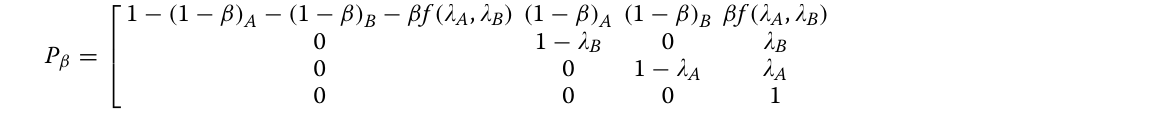
The Markov state transition β-factor model and its associated state transition matrix are used to enhance the ‘one-out-of-two’ Markov diagram state model depicted in Fig. 3, to investigate the impact of CCF on the system reli- ability performance considering imperfect repair